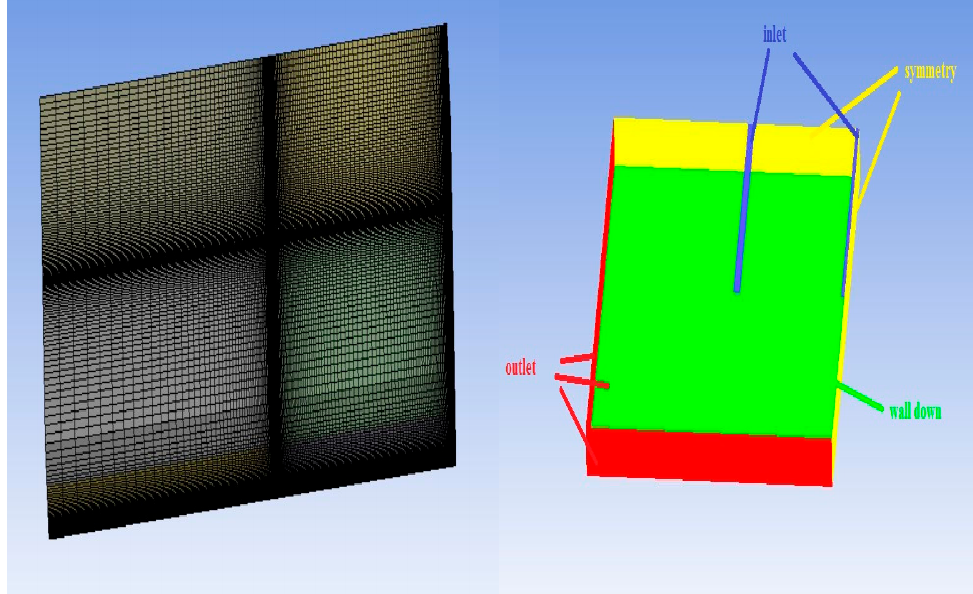
Figure 10. Calculation domain for the multi slot jet (three jets), H/B = 4.